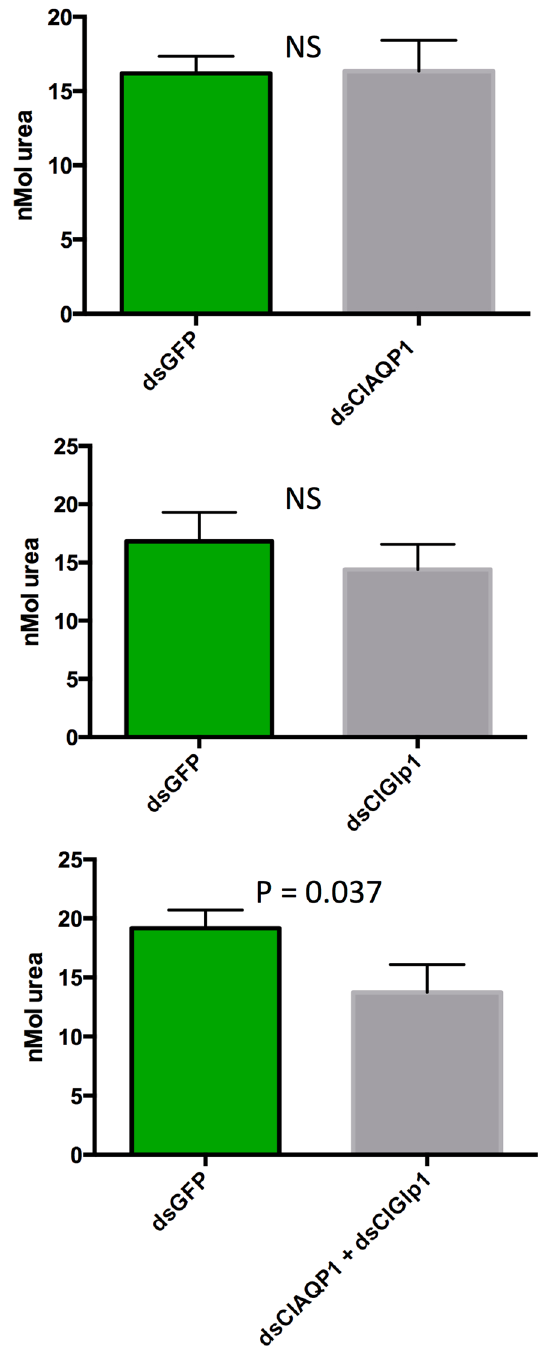
Figure 7. Effect of RNAi on urea excretion after a bloodmeal. All controls were injected with dsRNA against GFP. ( A ) RNAi of ClAQP1. ( B ) RNAi of ClGlp1. ( C ) Double knockdown of ClAQP1 and ClGlp1. The graph shows mean ±